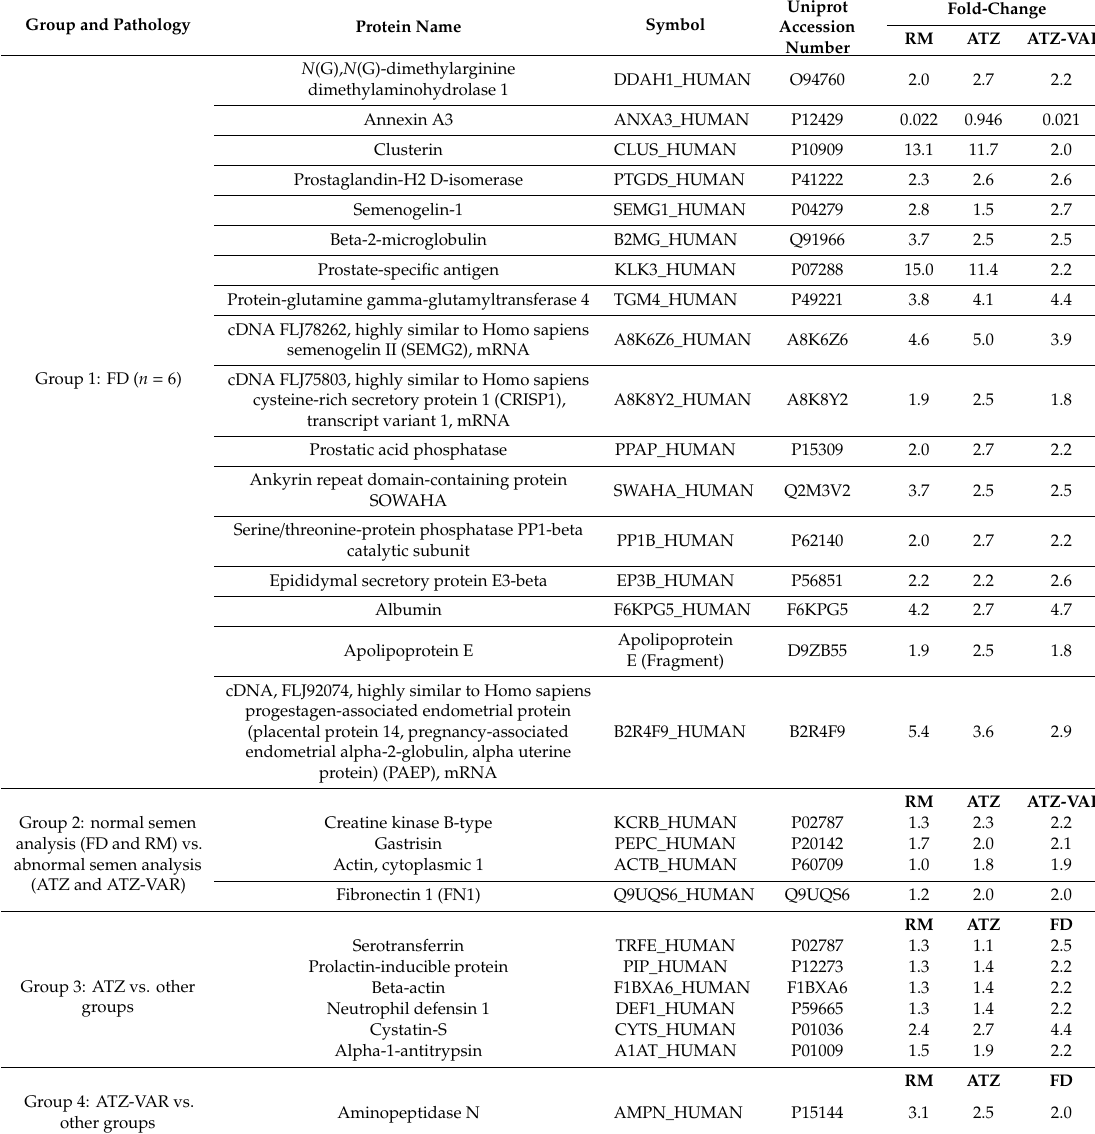
Table 2. Proteins with di ff erential expression in seminal plasma from fertile donor group vs. patient groups analyzed.